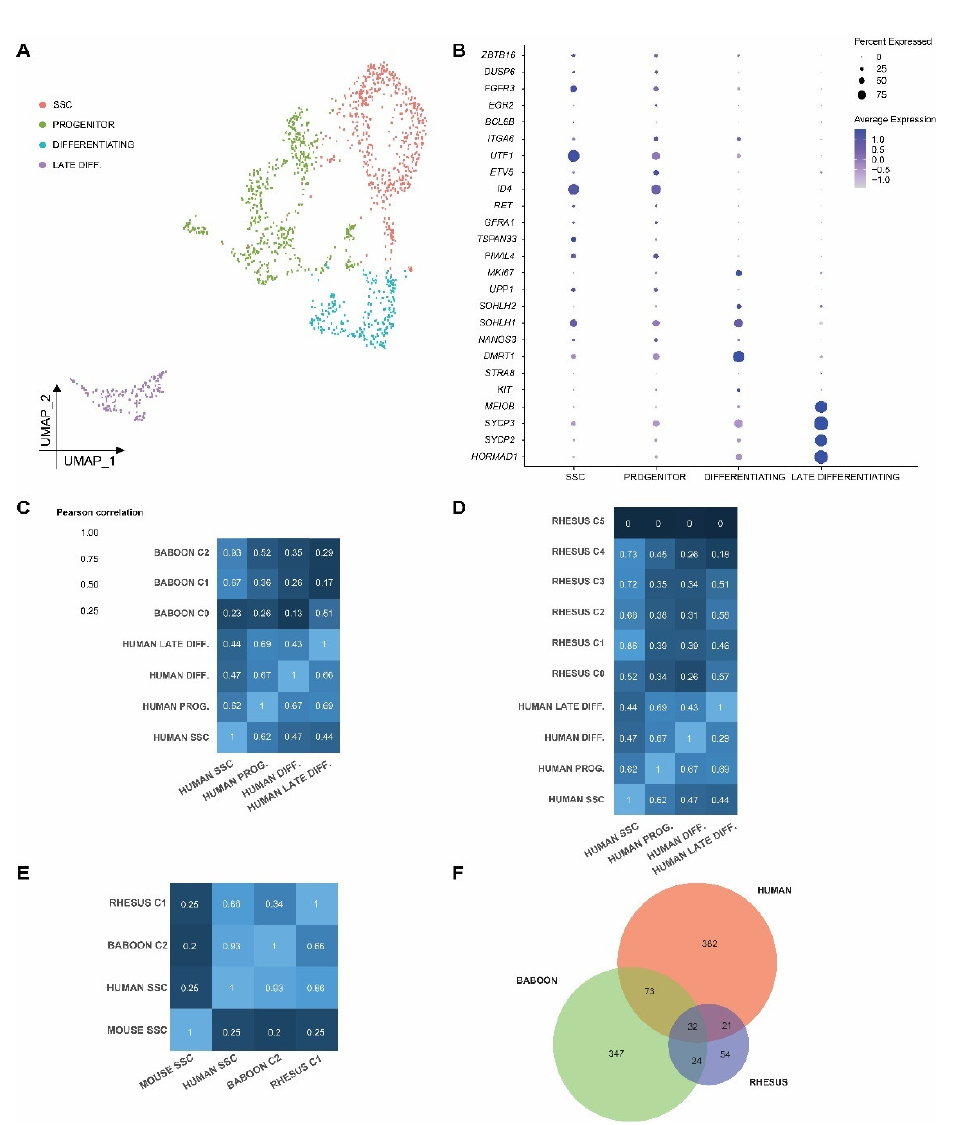
Figure 3. Cross-species comparison of putative human SSCs revealed analogous cell types in baboon and rhesus and unique markers of primate SSCs. ( A ) UMAP plot colored by cell type annotation represents human germ cells subsets ( n = 1451). ( B ) Dot plot shows the expression of selected markers for each germ cell subset seen in the UMAP plot. The size of the dot represents the percentage of cells within a cell type, while the color encodes the average expression level across all cells within a cell type (blue is high). ( C – D ) Correlation heatmaps show the comparison of the human SSC cluster with ( C ) baboon or ( D ) rhesus unbiased spermatogonial clusters, colored based on the Pearson correlation coefficient. ( E ) Correlation heatmap shows the comparison of putative SSC clusters from mouse, human, baboon, and rhesus germ cell datasets, colored based on the Pearson correlation coefficient. ( F ) Venn diagram shows the comparison of genes differentially expressed in the human SSC cluster ( n = 508) with genes differentially expressed in the putative SSC clusters in baboon and rhesus. Thirty-two genes were conserved in humans, baboons, and rhesus macaques and represent markers of putative